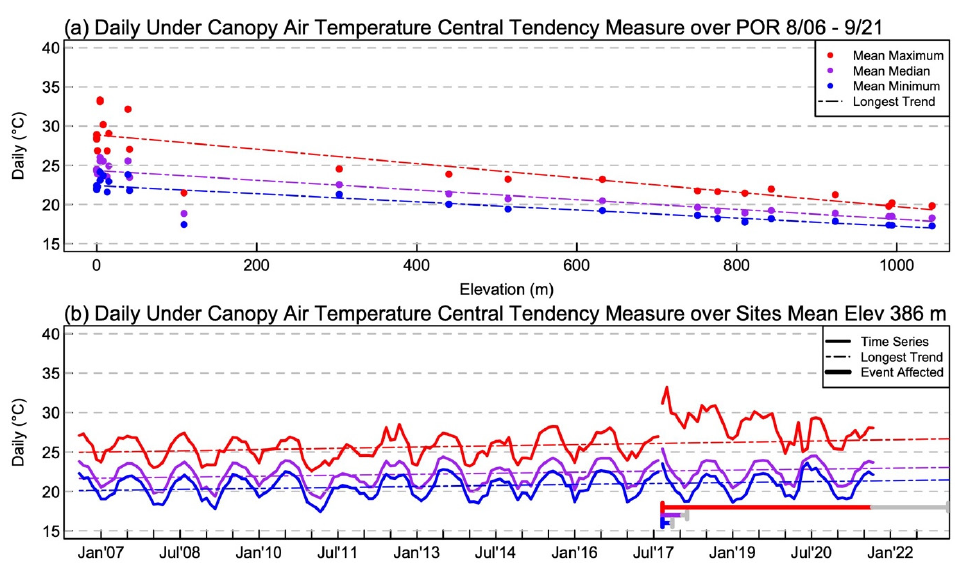
Figure 3. Average of the statistical calculations on the under-canopy air temperature for daily maximum, median, and minimum. Plot ( a ) shows the site period of record average values as points with the trend lines of magnitude with elevation. Plot ( b ) shows the periodic component timeseries (each 1 month) averaged over the sites as thick lines, with thin dashed trend lines of magnitude with time at the average site elevation (386 m). The colors signify the same variable across the plots. Only the longest trend calculated is shown, from the pre-hurricane data. The estimated event-affected (hurricane) periods are shown in thick bars on the bottom of plot with the gray part of the bars as the 90% confidence intervals around the end